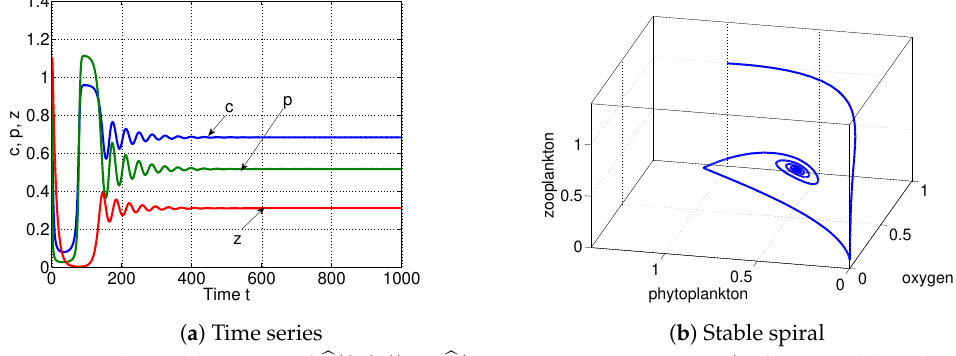
Figure 4. The stable nature of (cid:98) E ( (cid:98) c , (cid:98) p , (cid:98) z ) ≡ (cid:98) E ( 0.682267,0.515313,0.30855 ) of system (1) under the parametric set: { A = 1.8, c 0 = 1, δ = 1, c 2 = 1, m = 0.5, B = 1.8, c 1 = 1.0, γ = 0.7, σ = 0.1, ν = 0.01, µ = 0.1, h = 1.2, a = 3.0, η = 0.7, c 4 = 1, g = 0.3, and c 3 = 1 } . Initial conditions: c ( 0 ) = p ( 0 ) = z ( 0 ) = 1.